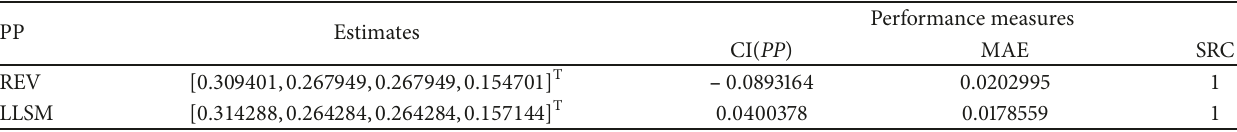
Table 2: Values of the PCM-CMs denoted as CI( PP ) for A ( x ) and proposed characteristicsof PVs estimates ( ∗ ) quality in relation to the true PV for the case.